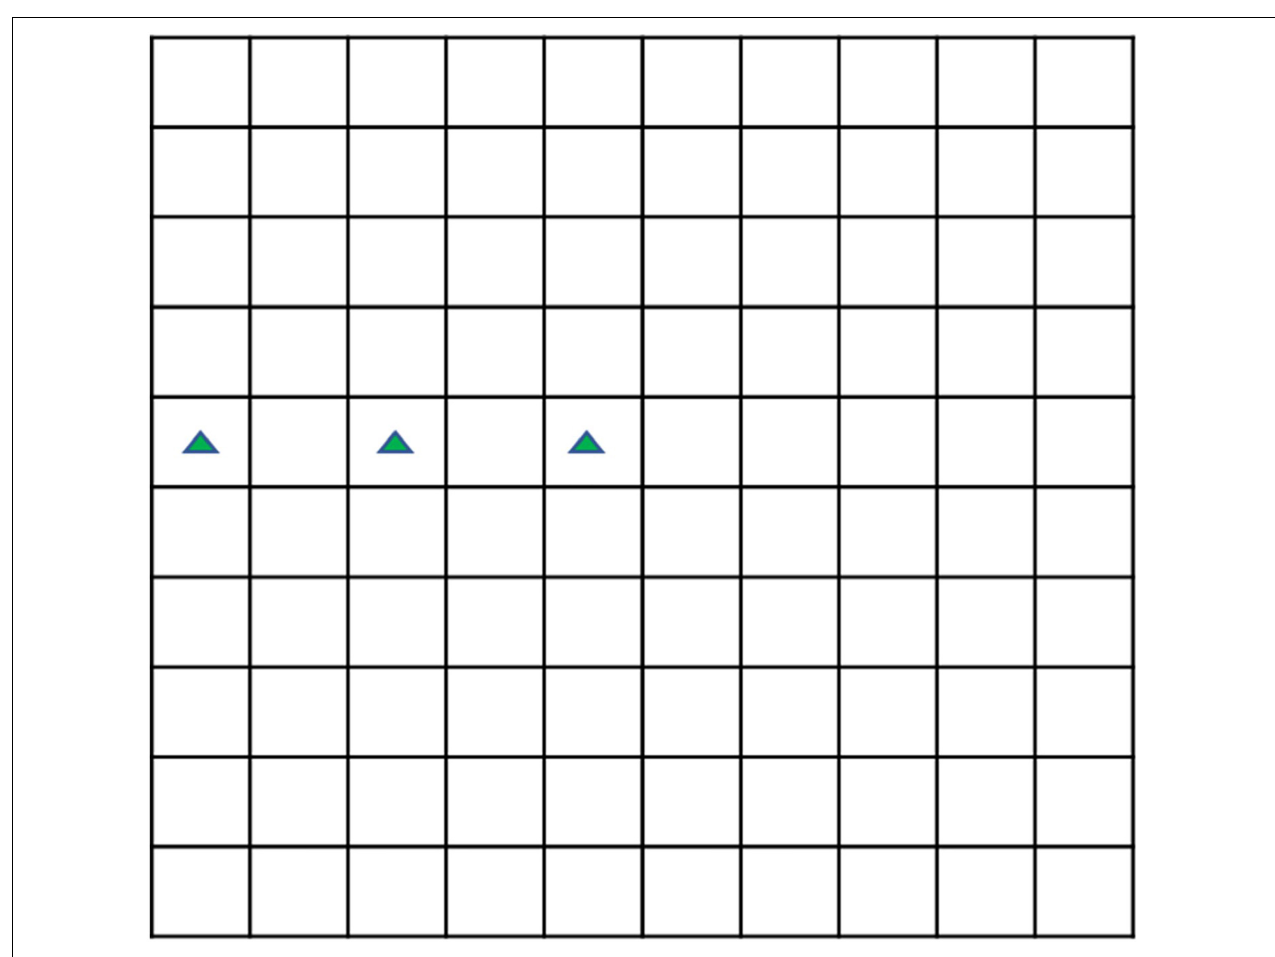
FIGURE 1 | The plane sketch of 0.1 mL Sedgewick Rafter cell.